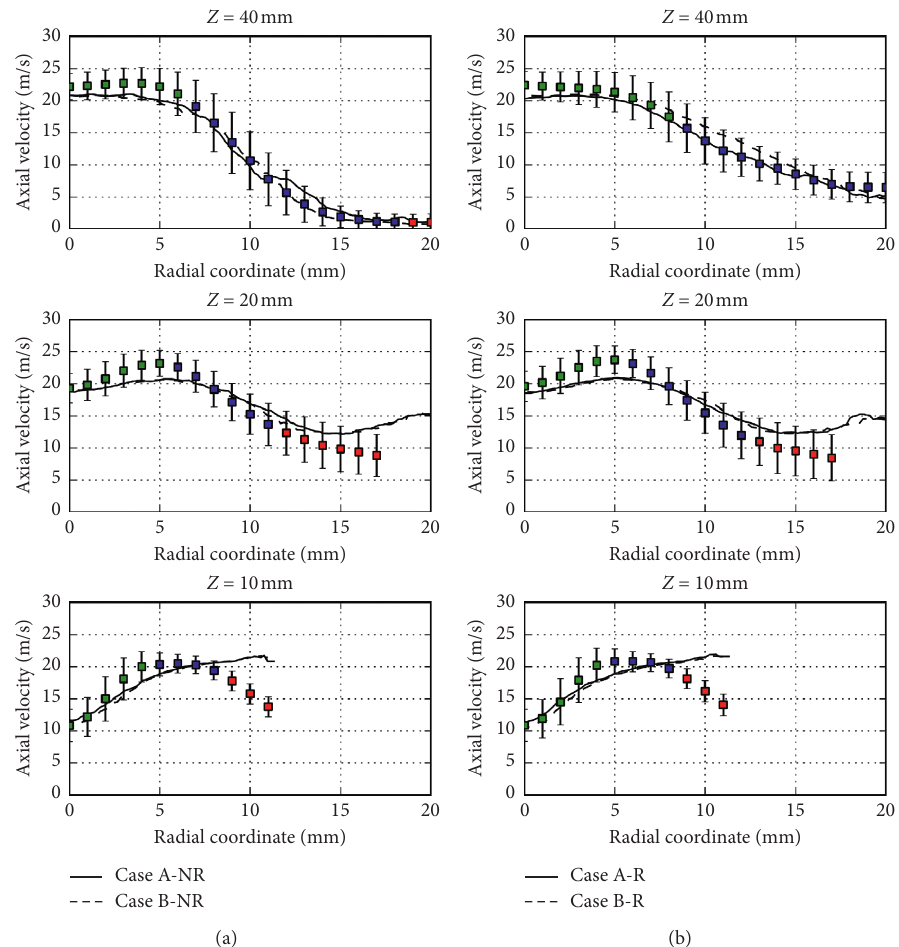
Figure 24: Radial profiles of droplet axial velocity for nonreacting (a) and reacting case (b). Symbols: experiments, solid line: case A dashed line: case